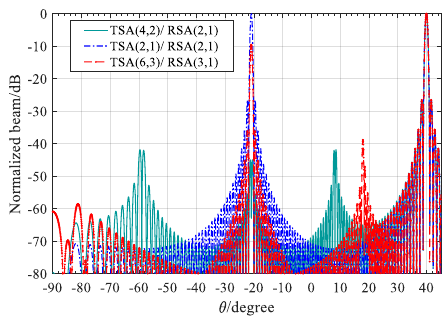
Figure 7. PW beam patterns comparison for